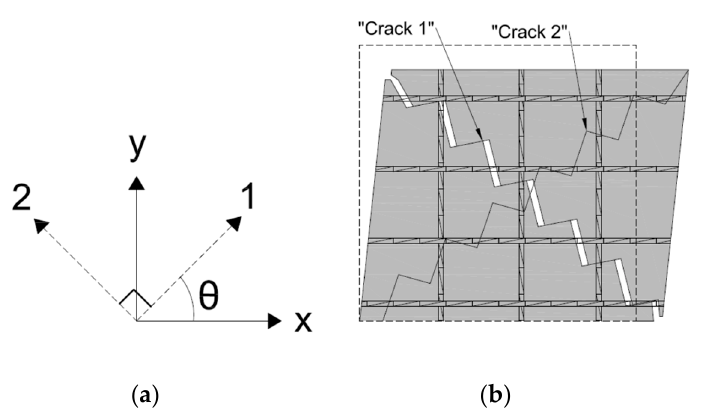
Figure 3. ( a ) Crack definitions and ( b ) Schematic of the slip–separation relationship of the active crack.